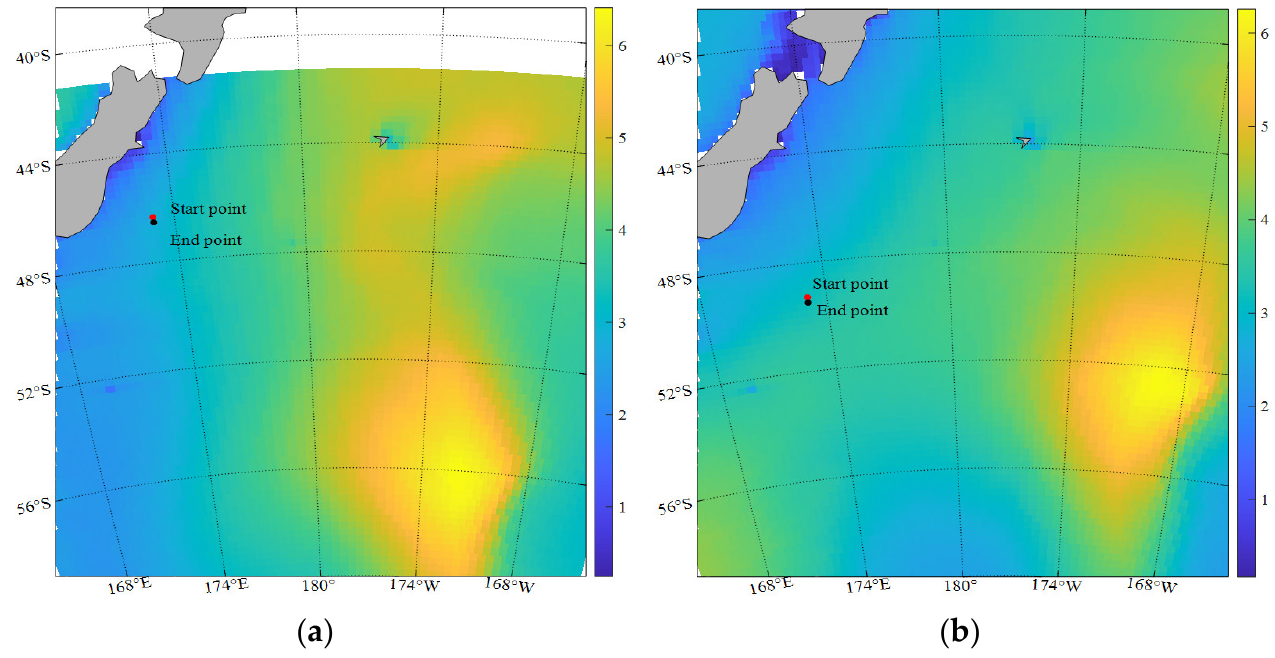
Figure 3. Weather forecast data—Equivalent wave height in meters: ( a ) 7 January 2020 at 01.00 p.m. local time; ( b ) 8 January 2020 at 04.00 a.m. local time.